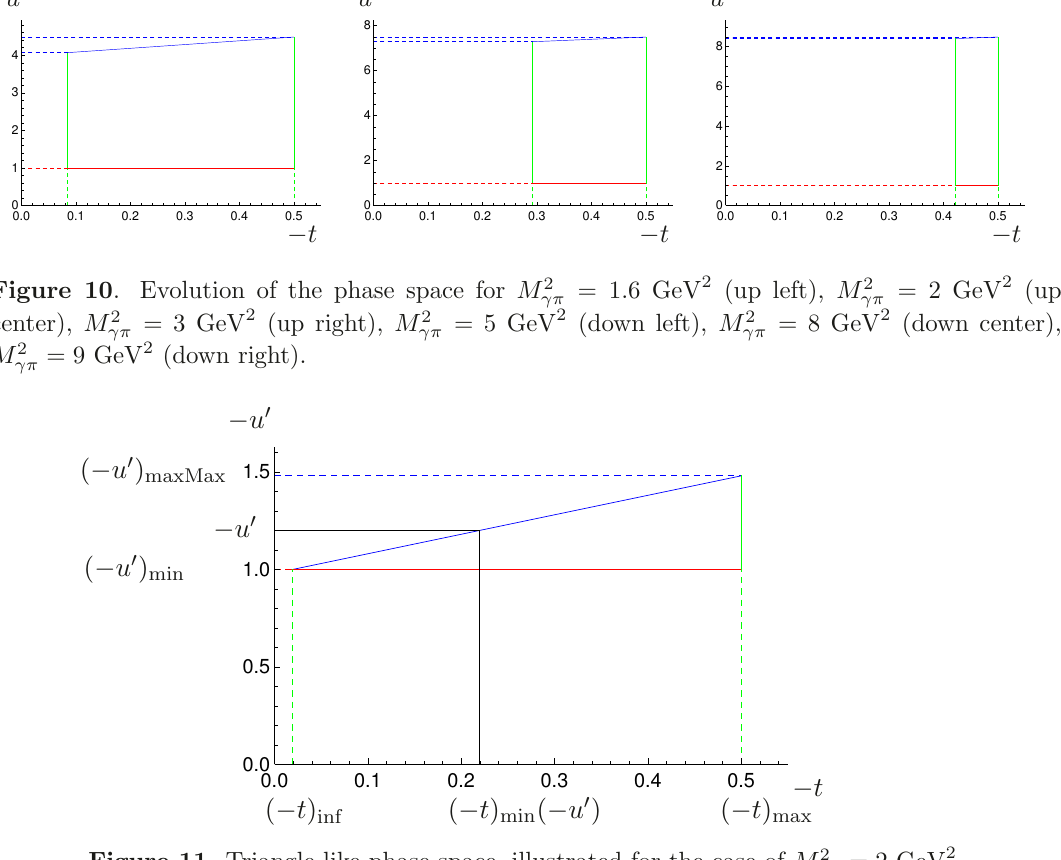
Figure 11 . Triangle-like phase space, illustrated for the case of M 2